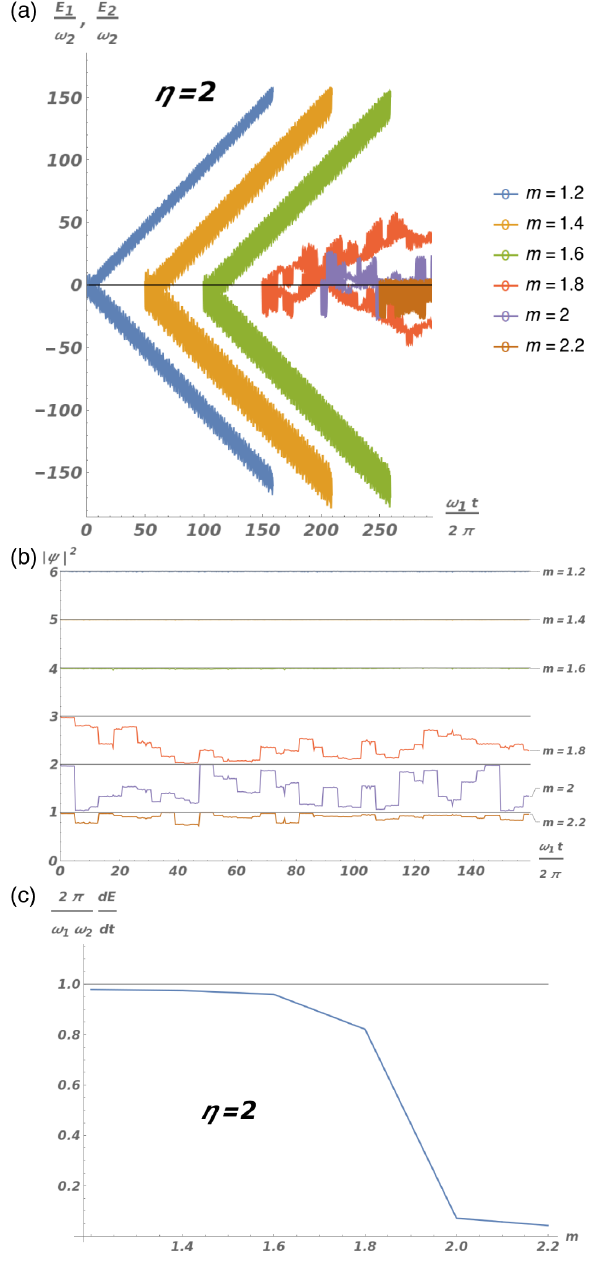
FIG. 4. TheenergyflowandfidelityforthemodelofEq.(28)inthe strong-drive regime, η ¼ 2 , ω 1 ¼ 0 . 1 , and ω 2 ¼ γω 1 ≈ 0 . 1618 . (a) The total work done by drives 1 and 2 as a function of time for different m ’ s. Each pair of lines is displaced on the time axis for clarity. The time axis is given in cycles of drive 1, while the work is normalized by ω 2 . The quantized rate corresponds to slope 1. (b)Fidelityvs time ofa state initializedintheinstantaneous eigenstate of H ð t ¼ 0 Þ and measured against the eigenstate of H ð t Þ . All fidelities start at 1 at t ¼ 0 and are offset vertically for clarity. (c)Thepowerpumpedasafunctionoftheparameter m averagedupto time t ¼ 2000 . The quantized pumping is marked by the gray line at dE=dt ¼ ω ω = 2 π .Theinitialphasesfortheseplotsare ϕ π = 10 , 1 2 1 ¼ 0 . The strong-drive regime realizes the topological pumping ϕ 2 ¼ prediction up to m ∼ 1 . 8 . Both fidelity and pumping deteriorate close to the phase transition because of the closing of the band gap.